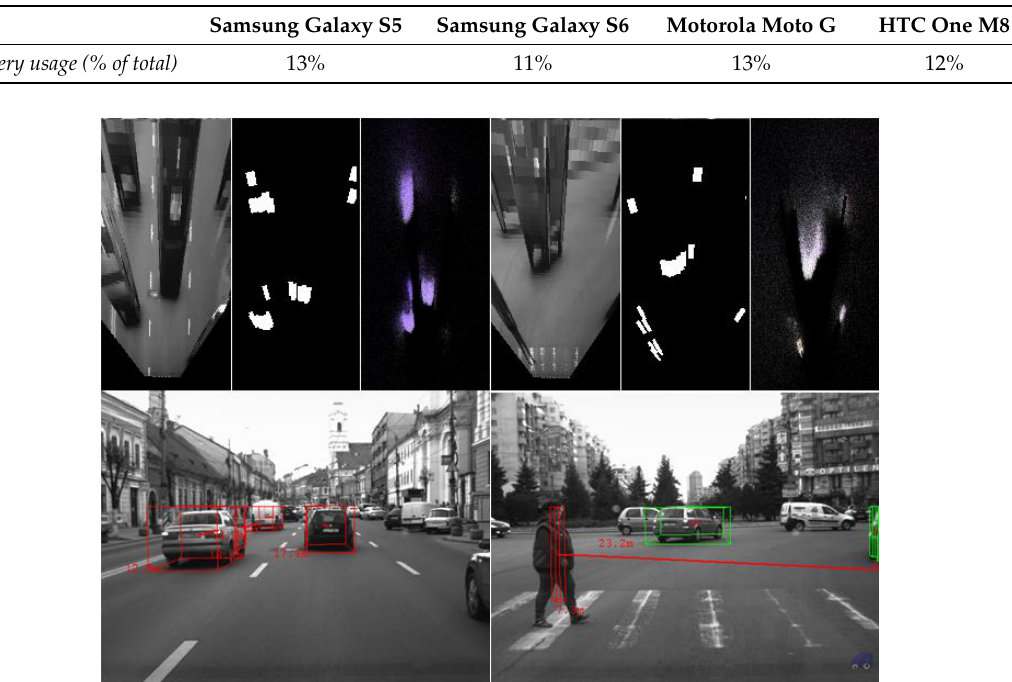
Figure 14. ( Left ) Three dynamic objects, going in the same direction as the observing vehicle; and ( Right ) pedestrian on a worn out crossing. In the distance, a vehicle is detected as stationary, as it waits to enter the roundabout. The IPM image, the segmentation result and the occupancy grid estimation are shown on top of the perspective image.